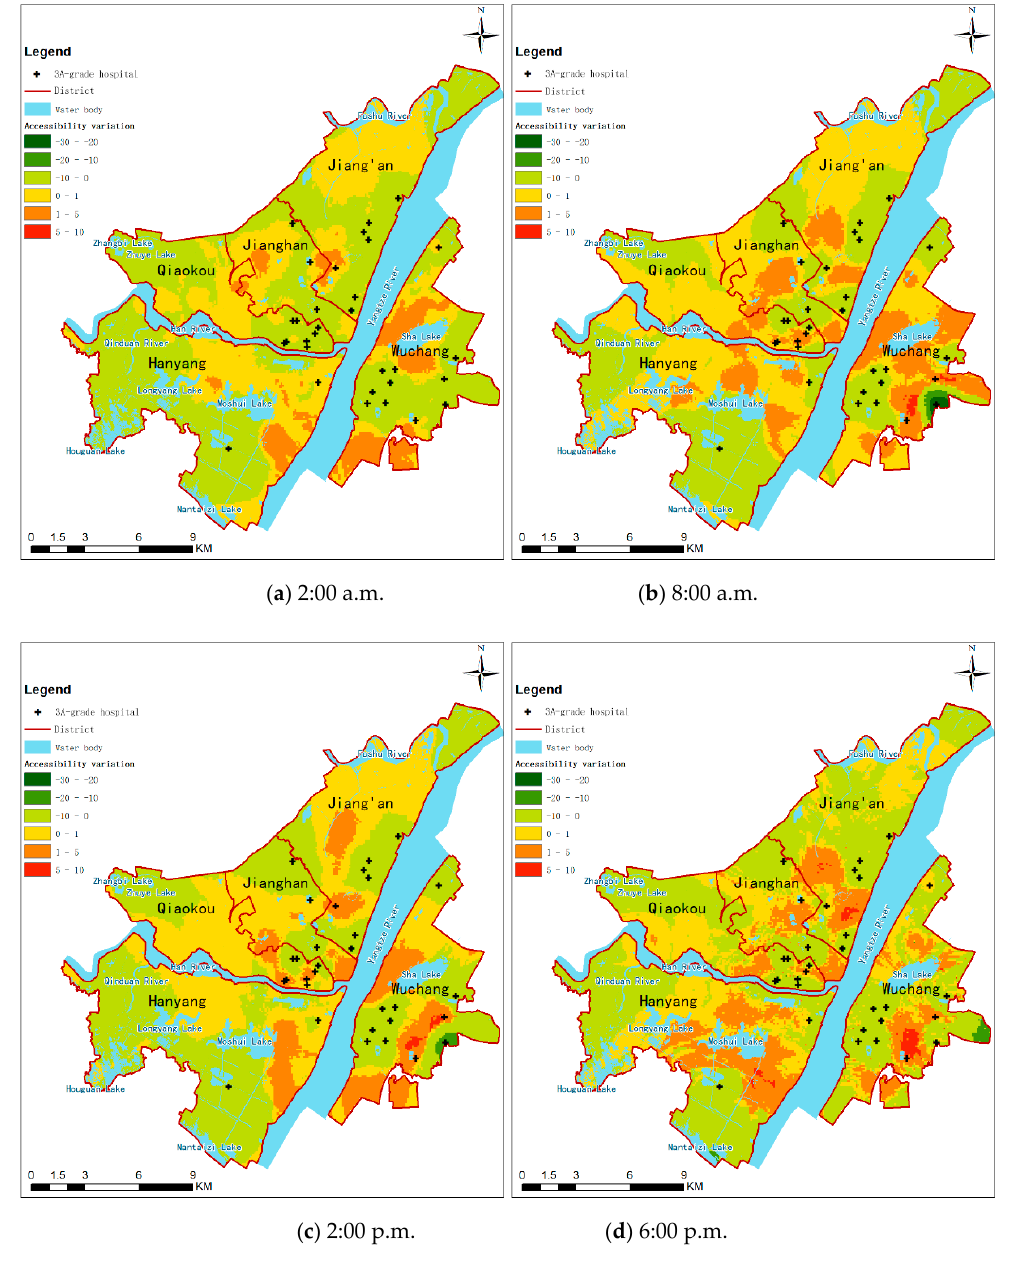
Figure 6. Accessibility variation calculated by two methods.